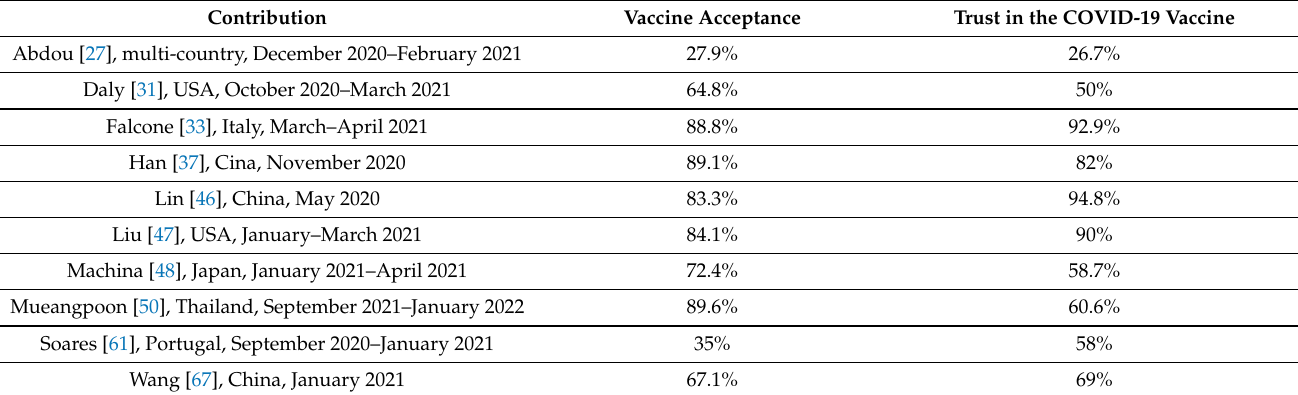
Table 3. Contributions considering both COVID-19 vaccine acceptance and COVID-19 vaccine